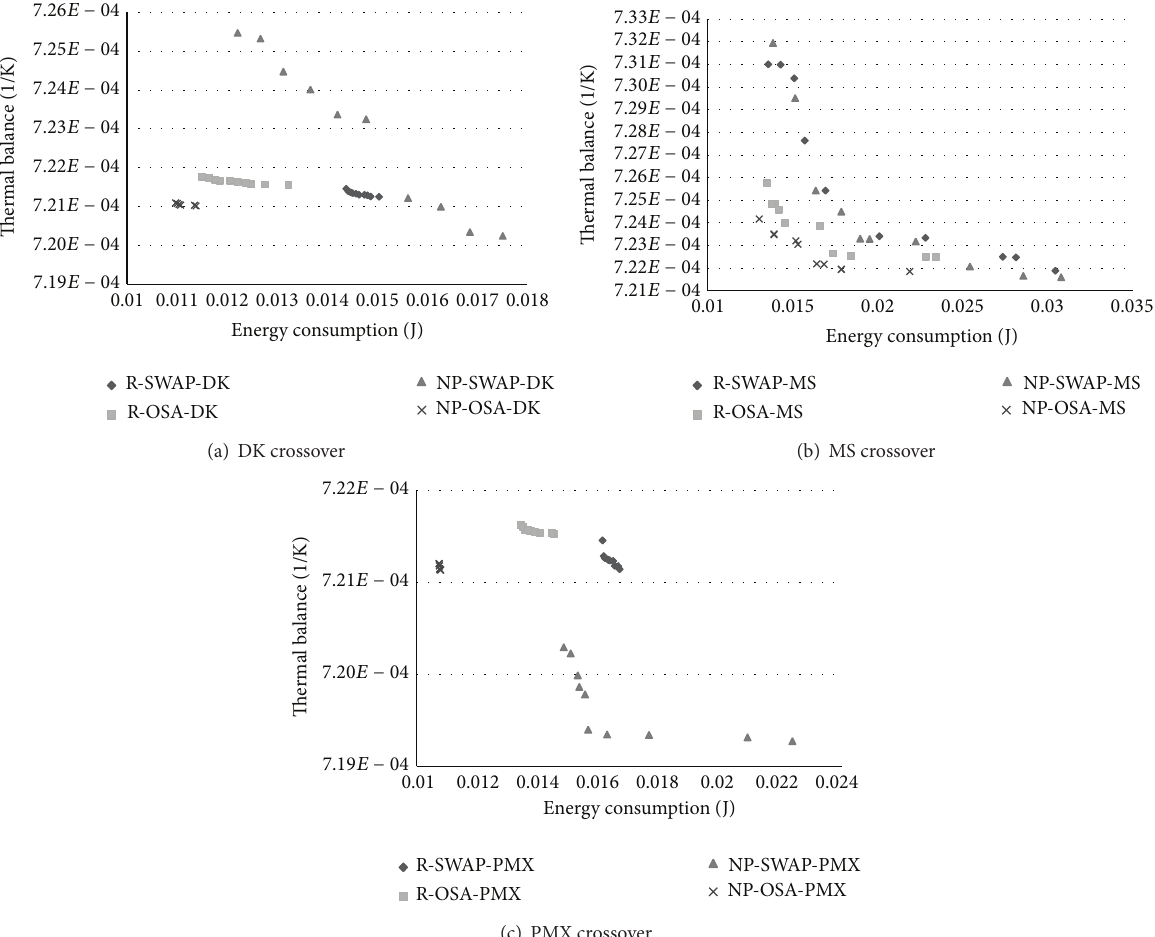
Figure 4: Pareto front by different crossover algorithms using 215-core benchmark. Different initial mapping and mutation combination are